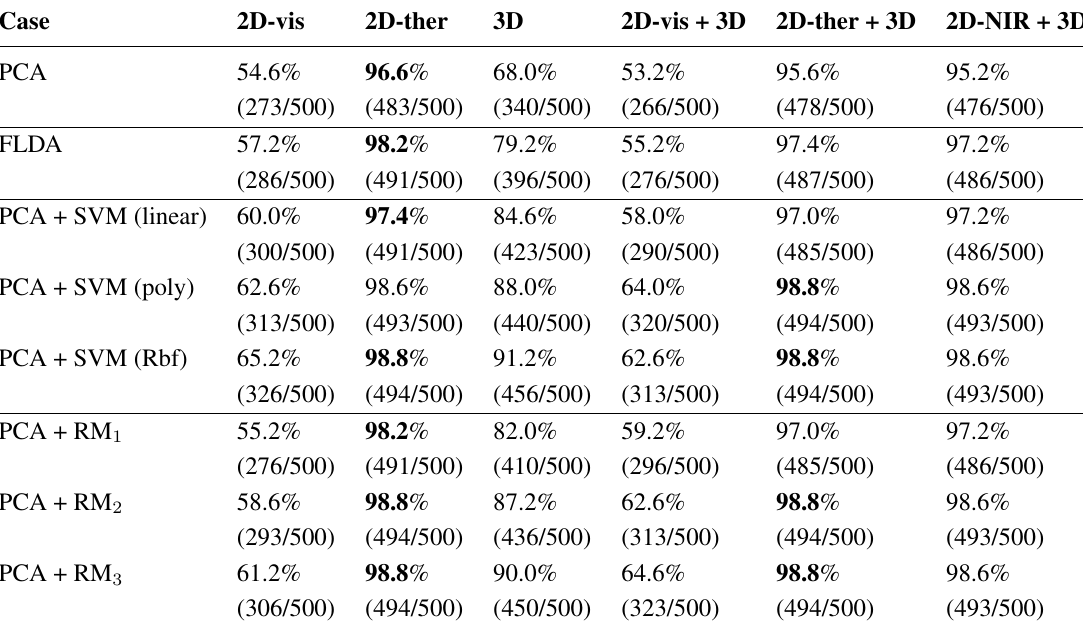
Table 2. Recognition rate with respect to light variation.